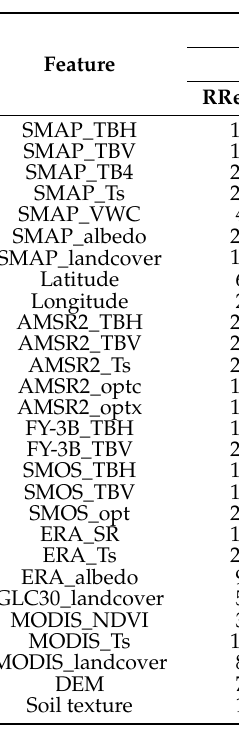
Table 4. The importance ranking of different feature selection